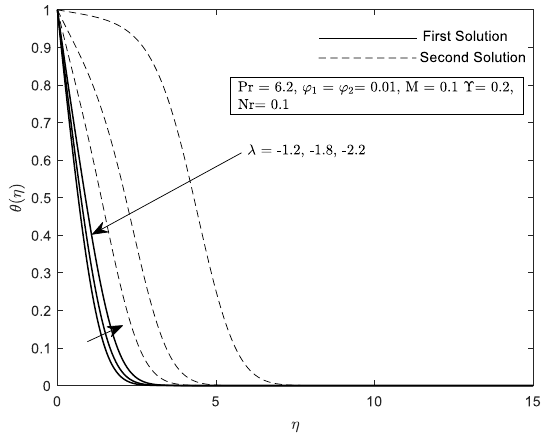
Figure 24. 𝜃(𝜂) on different 𝜆 .